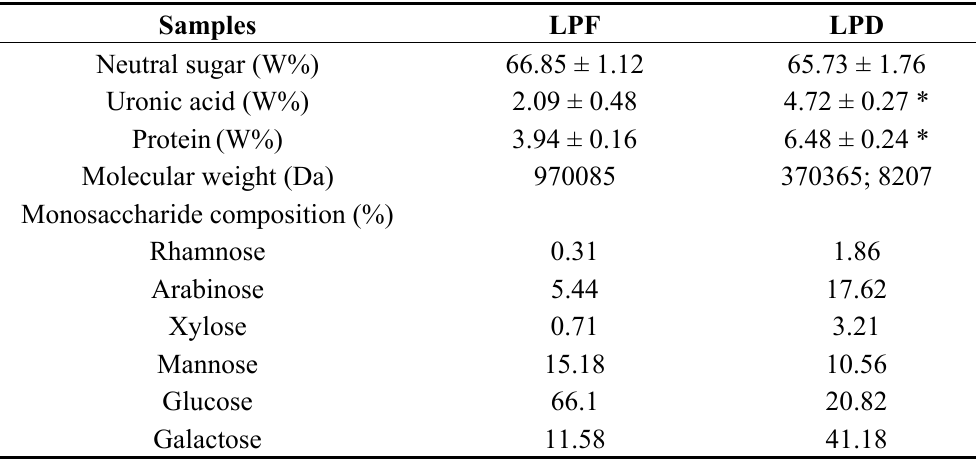
Table 1. The chemical compositions of litchi polysaccharides LPF and